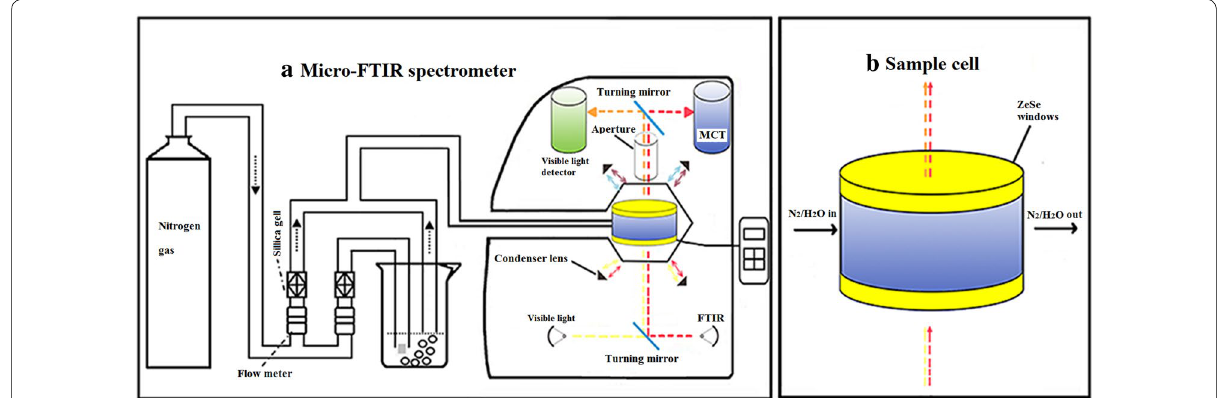
Fig. 1 Experimental setup for measurement of micro-FTIR